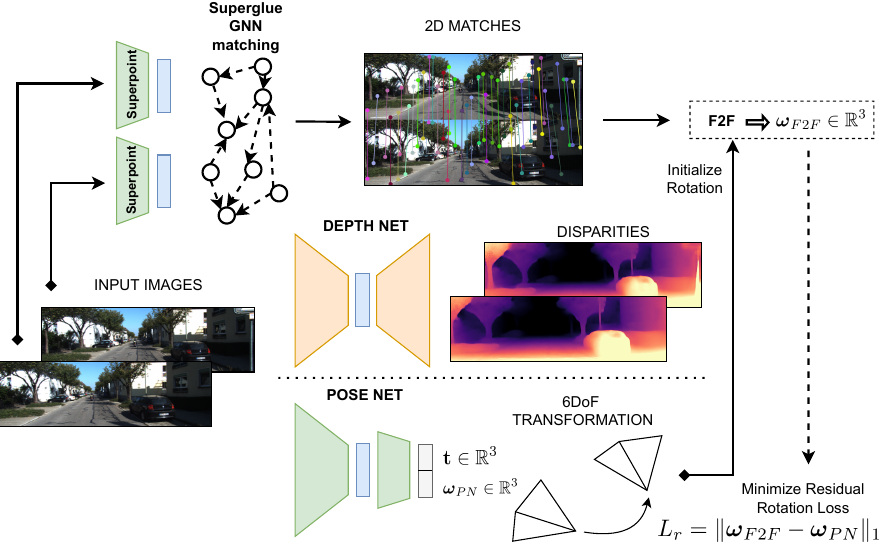
Figure 2. Diagram of RAUM-VO training. A sequence of images and 2D matches between pairs is the input for the training. The depth network takes only a single image to output a disparity map. The pose network outputs the 3D rigid transformation, as rotation and translation, between the two input images temporally ordered concatenated along the channel dimension. The matches are the input to the frame-to-frame rotation algorithm, whose output guides the training and adjusts the pose network estimation at test